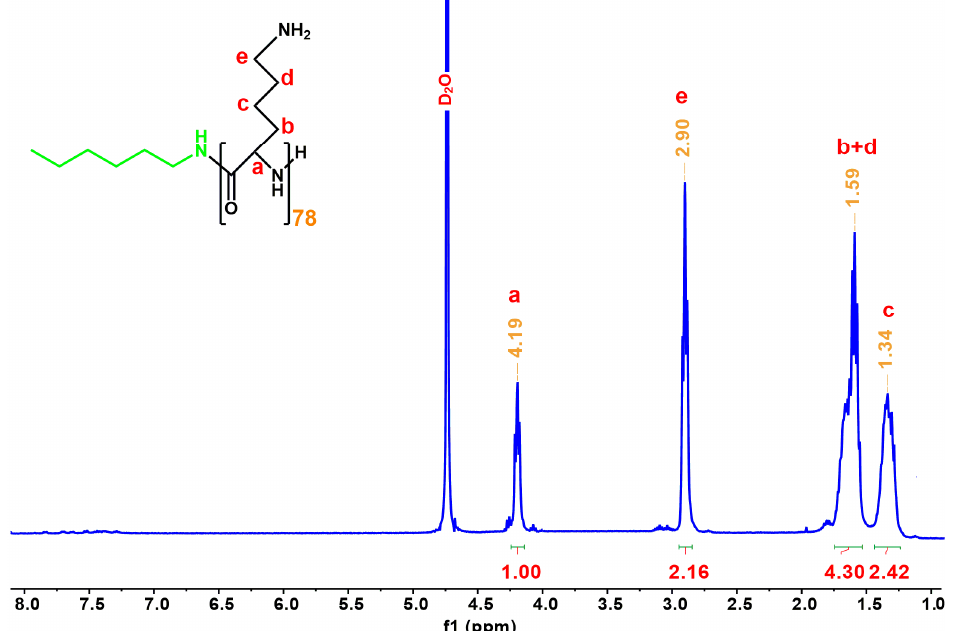
Figure 6. 1 H-NMR spectrum of the deprotected Poly( L -Lysine) 78 homopolymer.